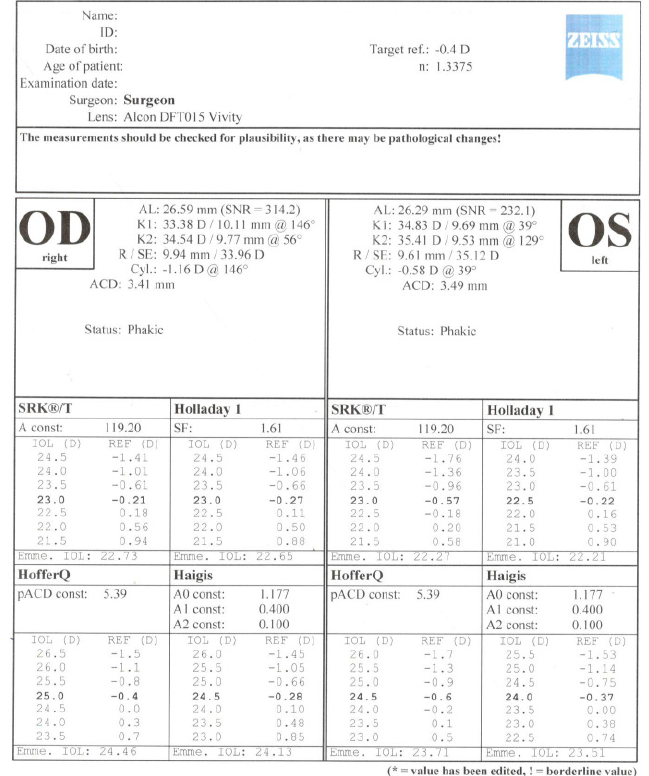
Figure 2. Result of intraocular lens power calculation using the IOL Master 500.